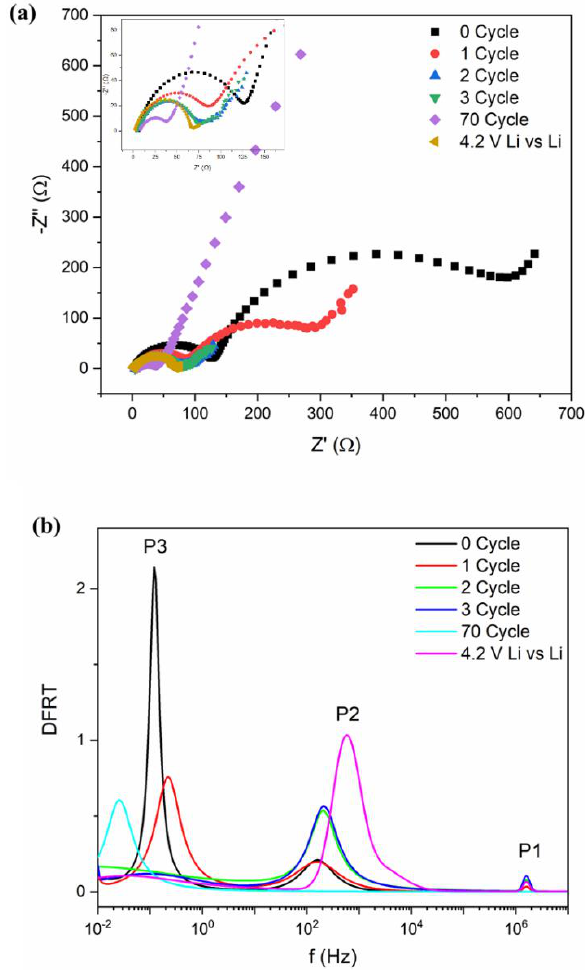
Figure 3. ( a ) Nyquist plots of impedance after different cycles along with symmetric Li cell. ( b ) DFRTs for Li-ion batteries after different cycling measurements. Inset of ( a ): zoom-in figure of im- pedance.